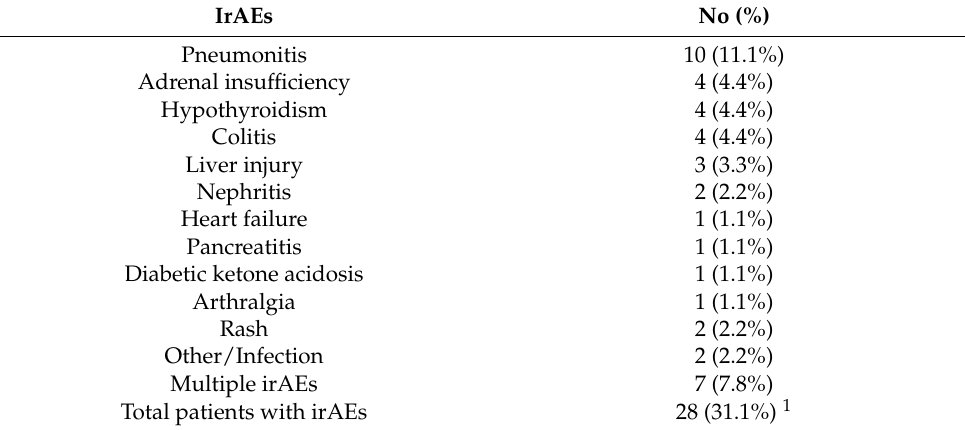
Table 1. List of irAEs. IrAEs No (%) Pneumonitis 10